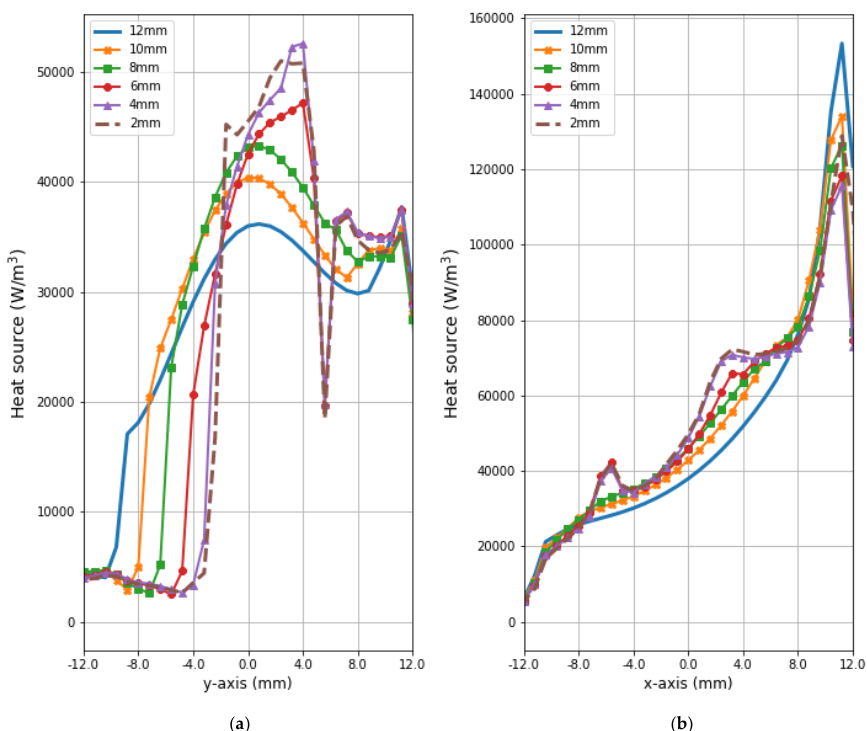
Figure 9. The distributions of power dissipation ( Q = ρ SAR) running through the center of tumors with different sizes along ( a ) the y -axis perpendicular to the antenna matrix; ( b ) the x -axis in the direction of the eight-dipole antenna array after the optimization procedure. Int. J. Mol. Sci. 2020 , 21 , x FOR PEER REVIEW